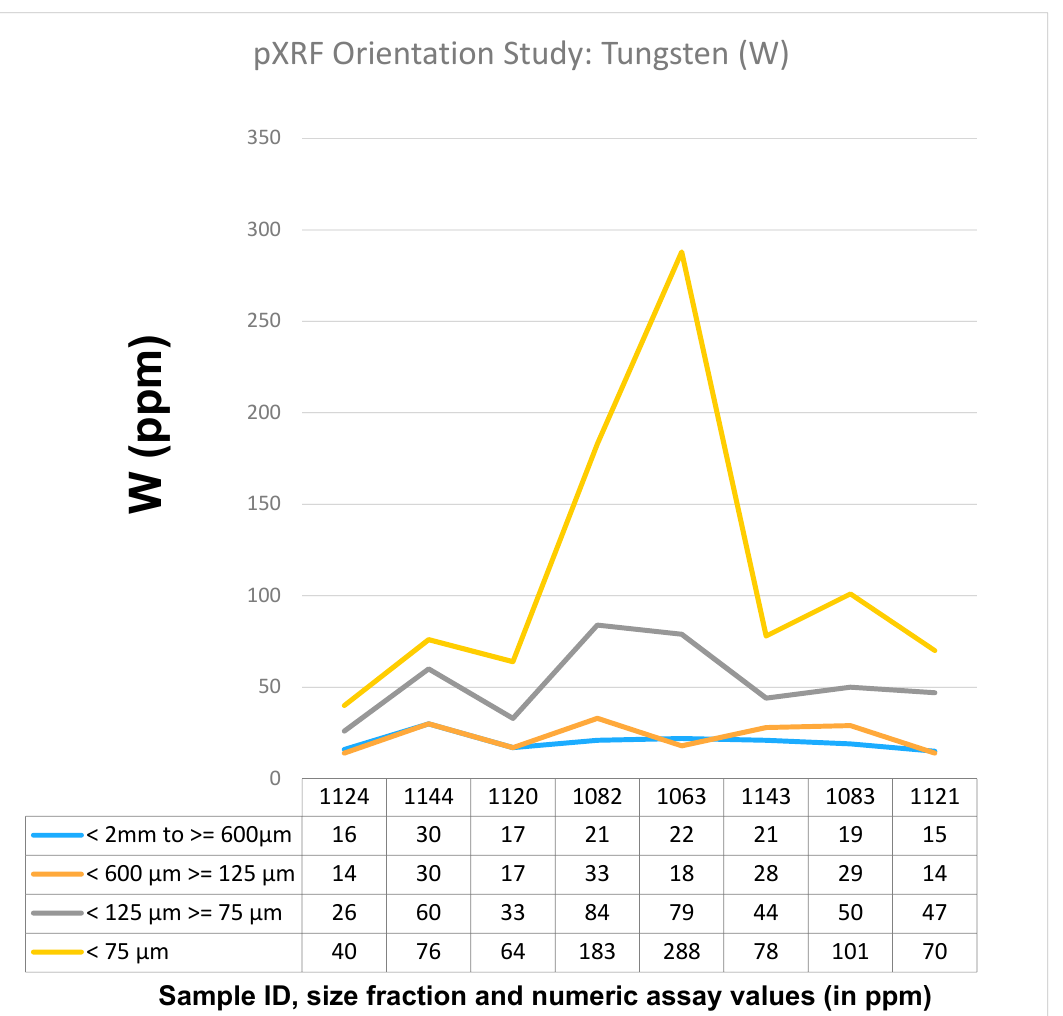
Figure 7. Results of an orientation study [29] carried out using portable pXRF equipment in order to determine the most suitable grain size fraction for the present stream sediment sampling campaign.